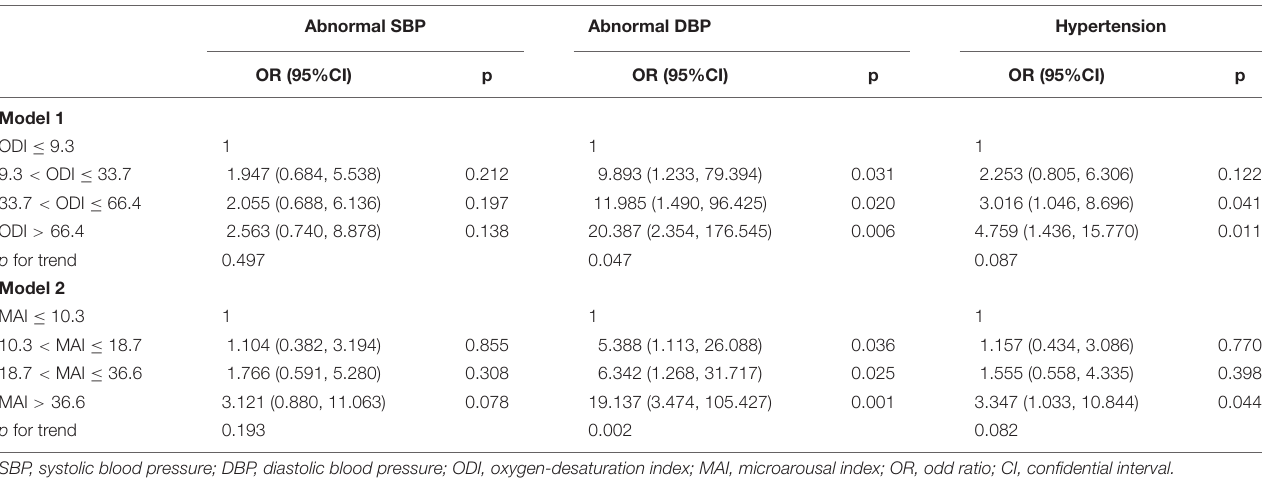
TABLE 3 | Logistic regression models of selected factors and abnormal blood pressure.